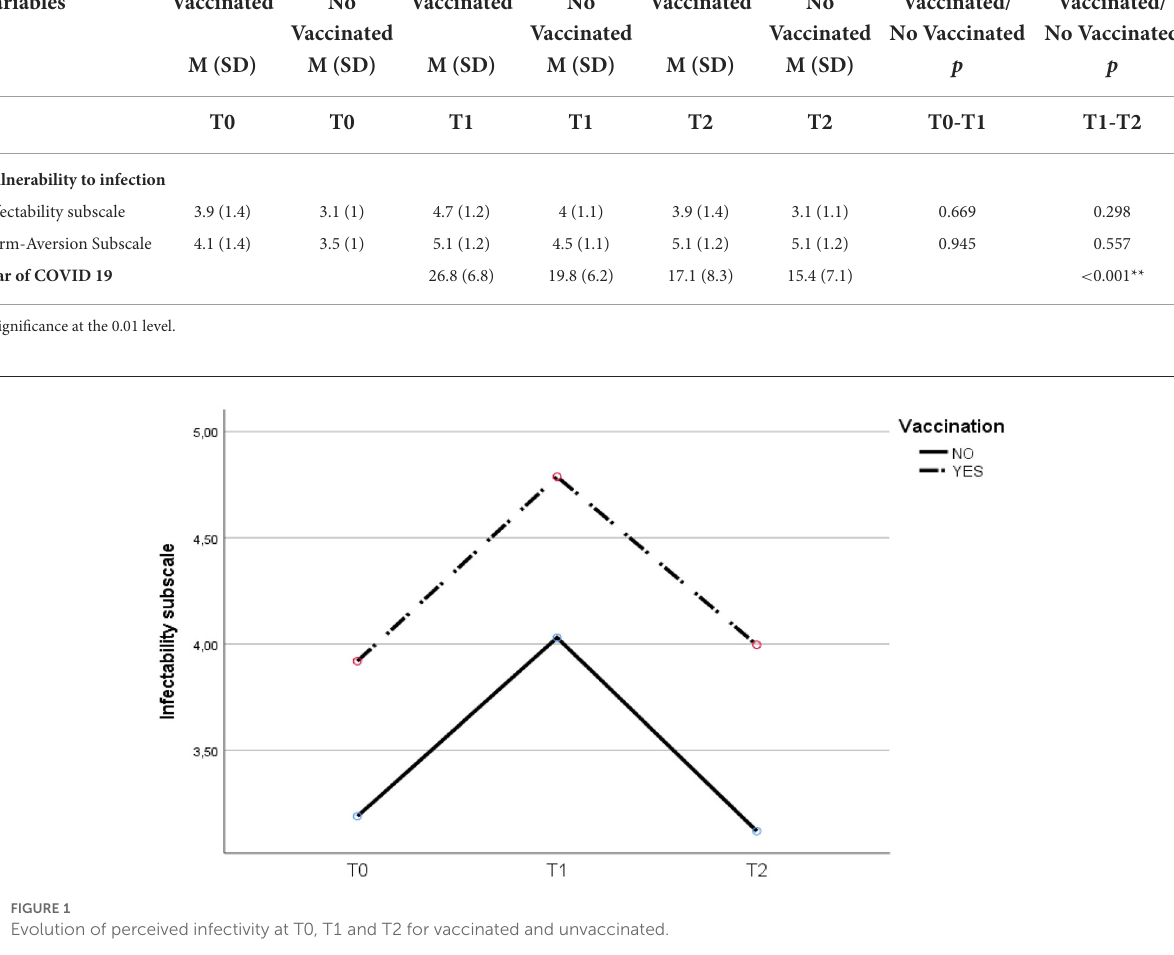
TABLE 4 Mean, standard deviation and significance according to vaccination for the variables of Vulnerability to infection and Fear of COVID-19 in T0, T1, T2. Variables Vaccinated No Vaccinated No Vaccinated